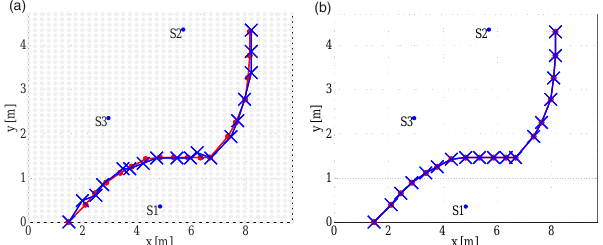
Figure 2. Path reconstruction using the scanning method and fin- gerprint (a) and trilateration (b) for noise-free simulations.